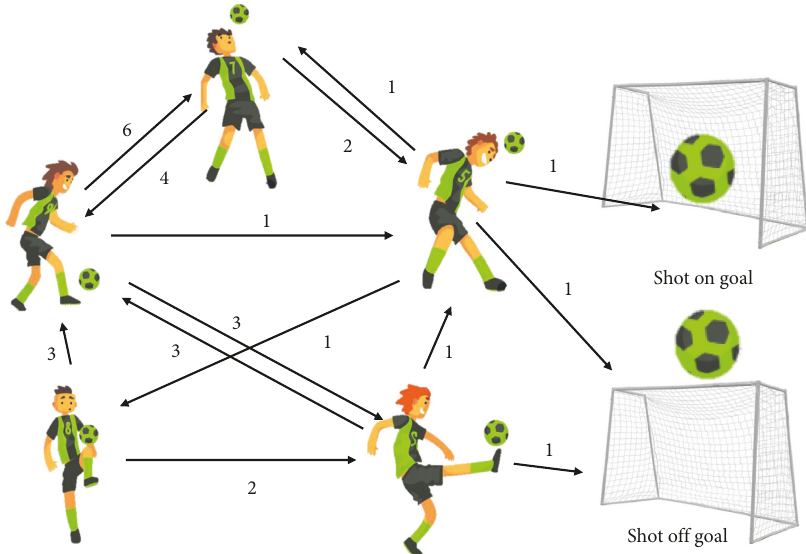
Figure 3: A small example for transition networks. Table 1: Centrality and its variants for sports social network analysis from 2012 to